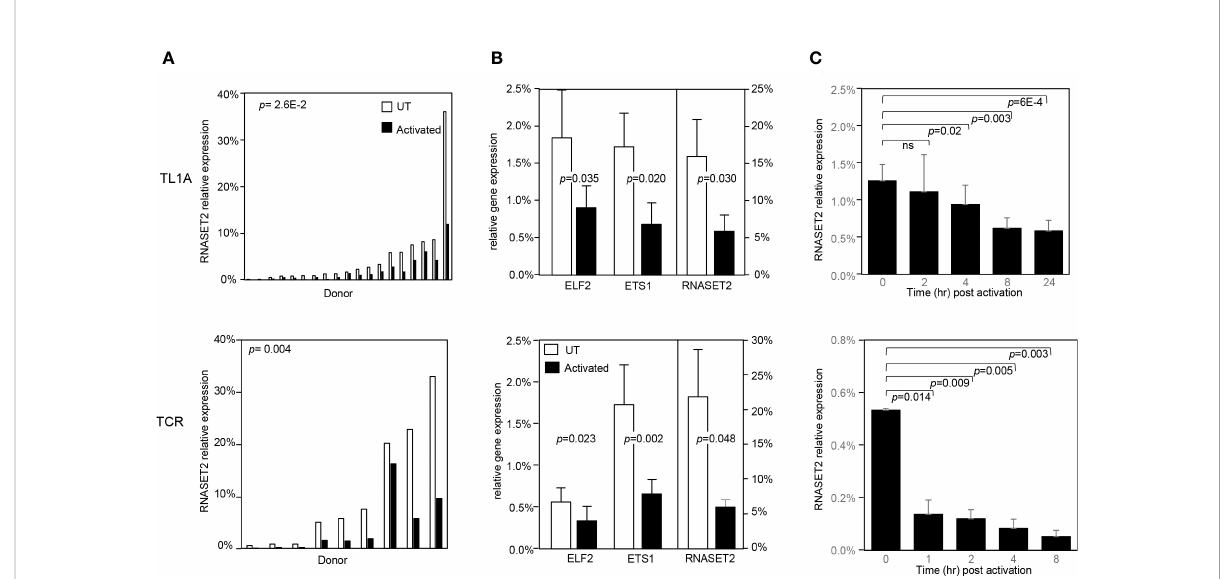
FIGURE 3 RNASET2 transcript downregulation is a hallmark of T cell activation. Expression of RNASET2 in CD4 + T cells activated with TL1A (upper panels) or TCR (lower panels). (A) Expression of RNASET2 is decreased in cells isolated from multiple donors (TL1A n =22, TCR n =9). (B) Concordant decrease in ELF2, ETS1 and RNASET2 (TL1A n =5, TCR n =6). Data show the mean ± SD. (C) Kinetics of RNASET2 expression following activation (TL1A n =8, TCR n =3). ns, not signi fi